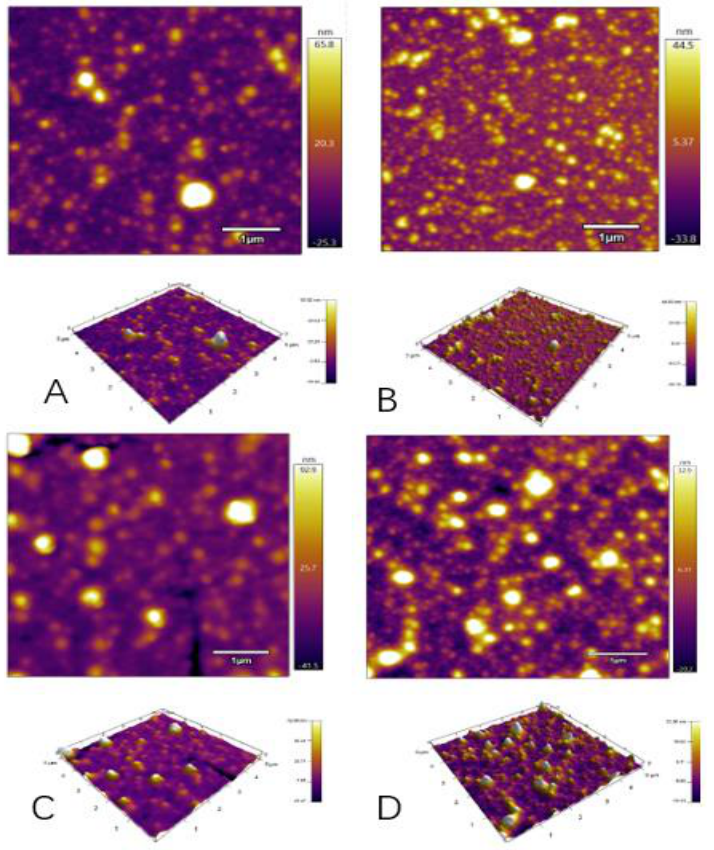
Figure 3. Atomic force microscopy images of EPI isolate cross-linked with different enzyme concen- trations ( A : S0, B : S1, C : S2, D : S3).